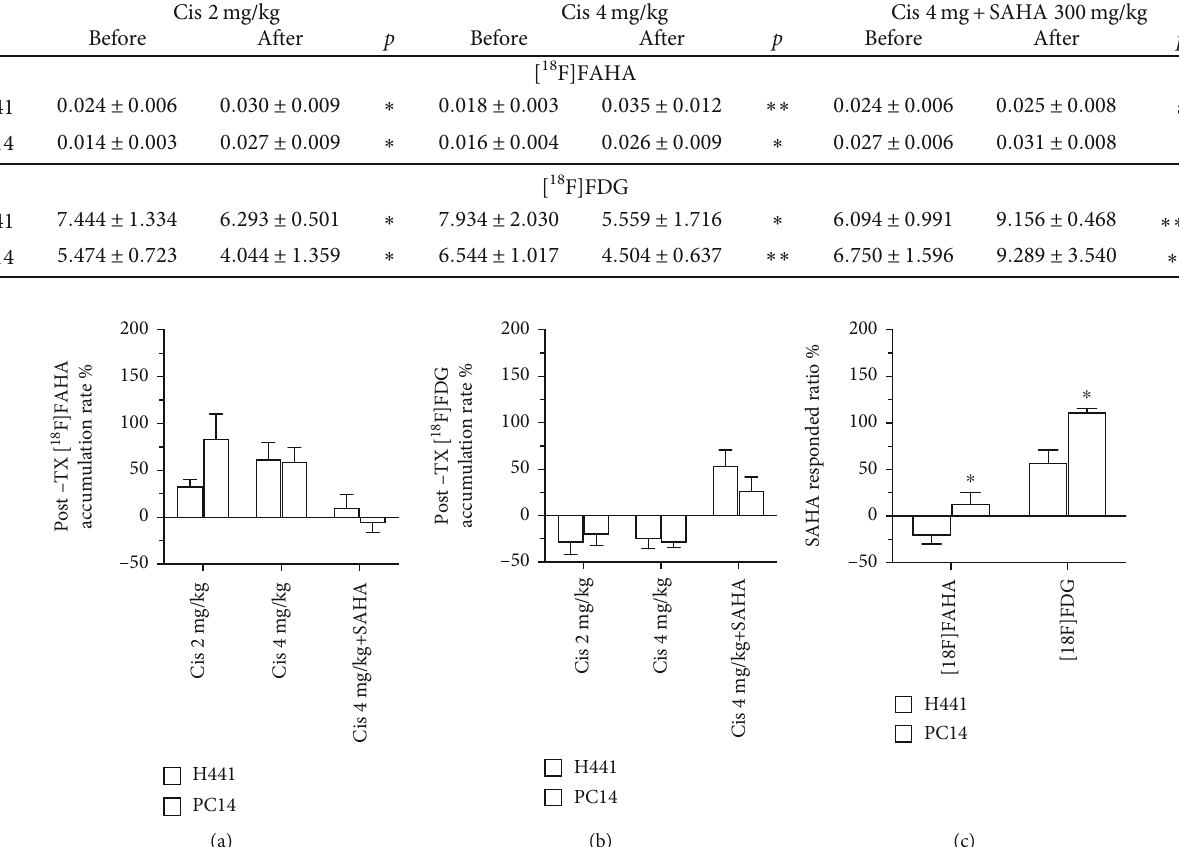
Figure 5: Comparison of [ 18 F]FAHA or [ 18 F] FDG accumulation in H441 and PC14 xenograft tumors postdrug administration. There were no signi fi cant di ff erences in the increase ratios for [ 18 F]FAHA (a) or [ 18 F] FDG (b) between H441 and PC14 xenograft tumors. (c) After treatment with cisplatin + SAHA, the [ 18 F]FAHA and [ 18 F] FDG ratios were signi fi cantly higher in PC14 xenograft tumors than H441 xenograft tumors. Data are mean ± SEM ; ∗ p < 0 : 05 , H441 vs.